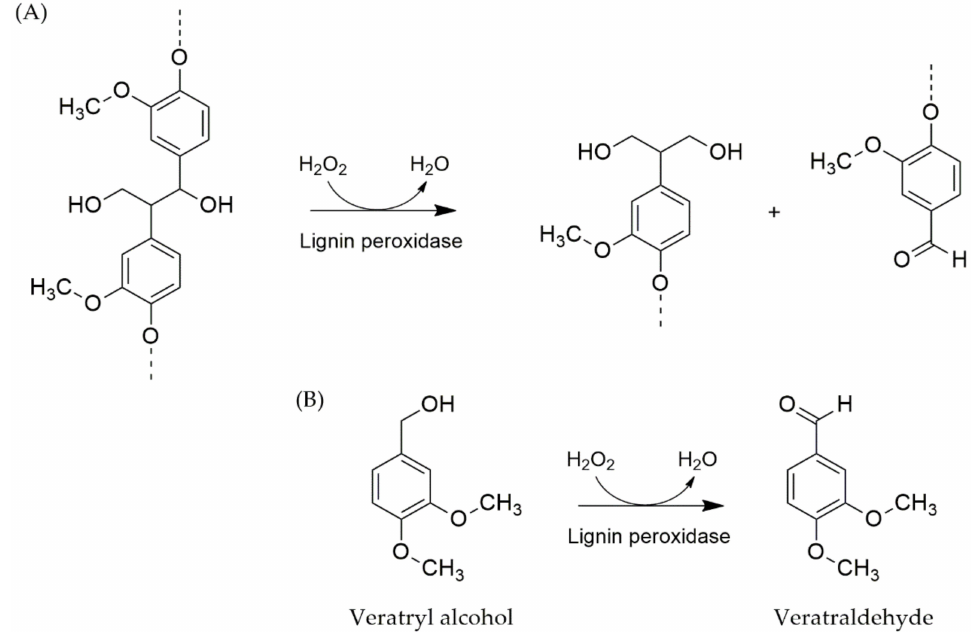
Figure 10. General reaction catalyzed by lignin peroxidase. ( A ) cleavage of C-C of lignin, ( B ) oxidation of veratryl alcohol is generally used to estimate the lignin peroxidase